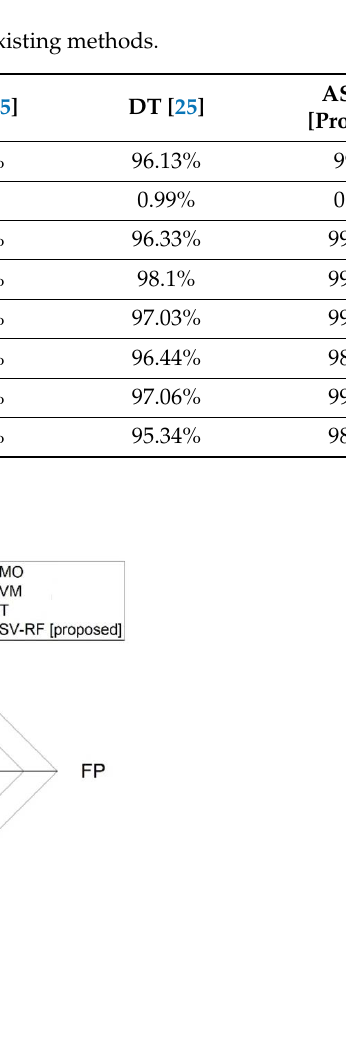
Figure 5. Results of f1-score, recall, sensitivity, and specificity